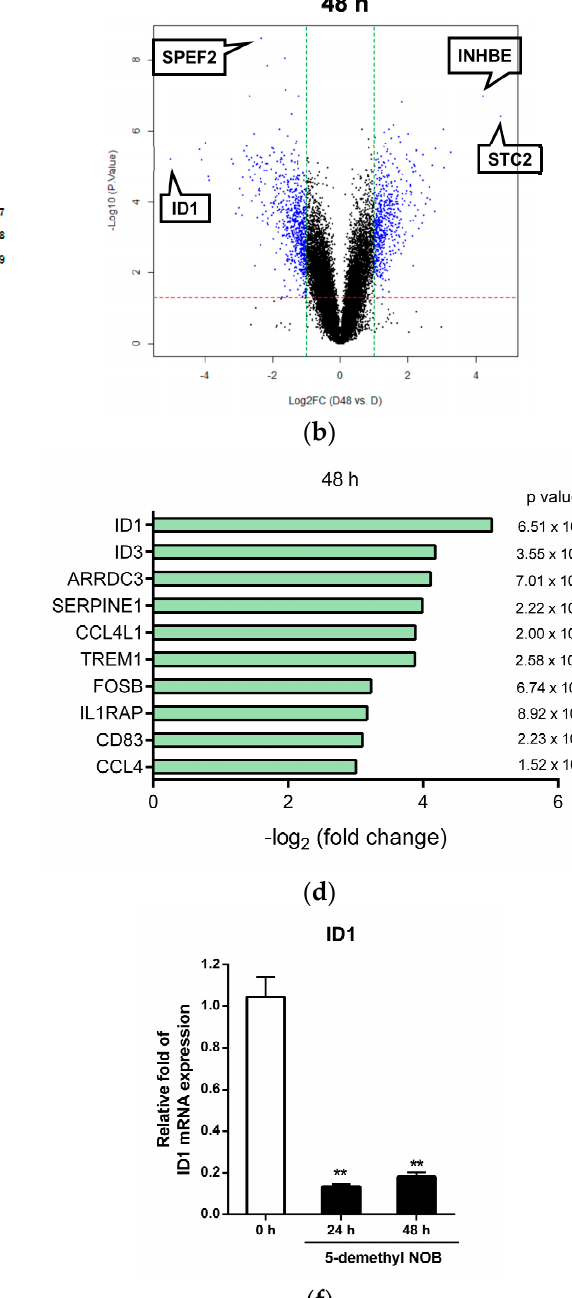
Figure 4. Microarray analysis of 5-demethyl NOB-treated THP-1 cells. THP-1 cells were treated with vehicle or 5-demethyl NOB (40 μ M) for 48 h, and the mRNA expression profiles were determined by human cDNA microarray. ( a ) Principal component analysis (PCA) of microarray data obtained from analyzing triplicate samples of vehicle (H001-H003) and 5-demethyl NOB (H007-H009) treatment. ( b ) Volcano plots of total gene expression profiles of the 5-demethyl NOB-treated cells. Each dot represents the mean expression ( n = 3) of the individual gene obtained from a normalized dataset. Genes above the cutoff values (the red and green dotted lines) were considered differentially expressed genes (DEGs) (blue dots). ( c ) The top 10 significantly upregulated and ( d ) downregulated genes in response to 5-demethyl NOB treatment. RT-qPCR analysis of ( e ) INHBE and ( f ) ID1 mRNA expression in 5-demethyl NOB-treated cells for 24 and 48 h. The data represent the mean ± SD of three independent experiments. ** p < 0.01 represents significant differences compared to the 0 h